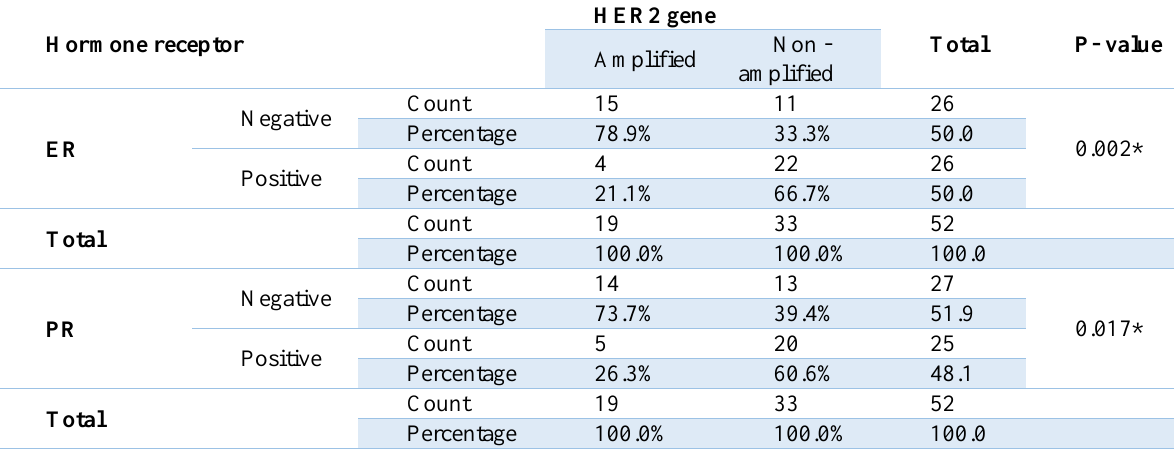
ER: estrogen receptor, PR: progesterone receptor, *: statistically significant